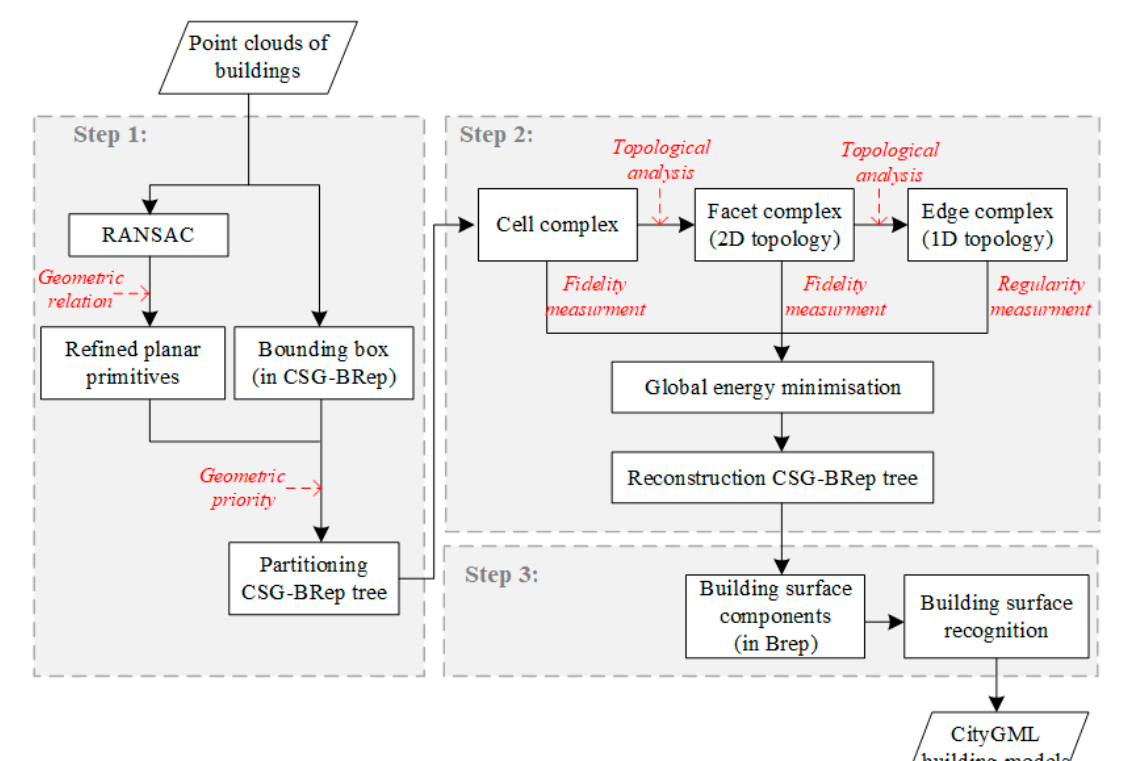
Figure 1. Flowchart of the proposed approach. Abbreviations: RANSAC, Random Sample Consensus; CSG-BRep, constructive solid geometry and boundary representation; CityGML, City Geography Markup Language.